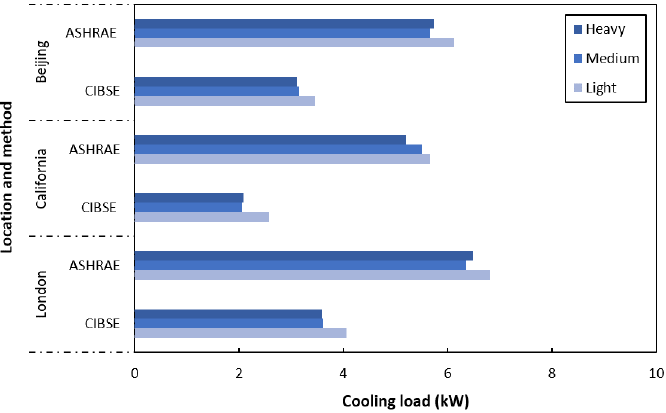
Figure 5. Thermal weight impacts on peak heat gains.